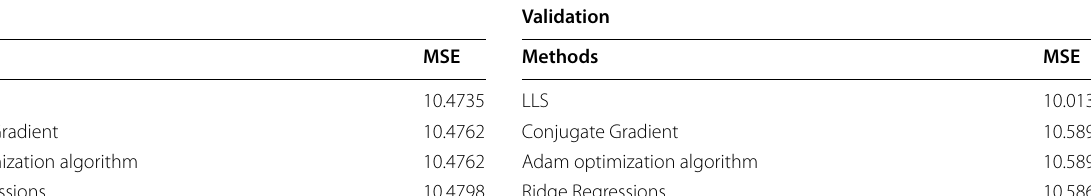
Table 3 MSE results of training Table 4 MSE results of the